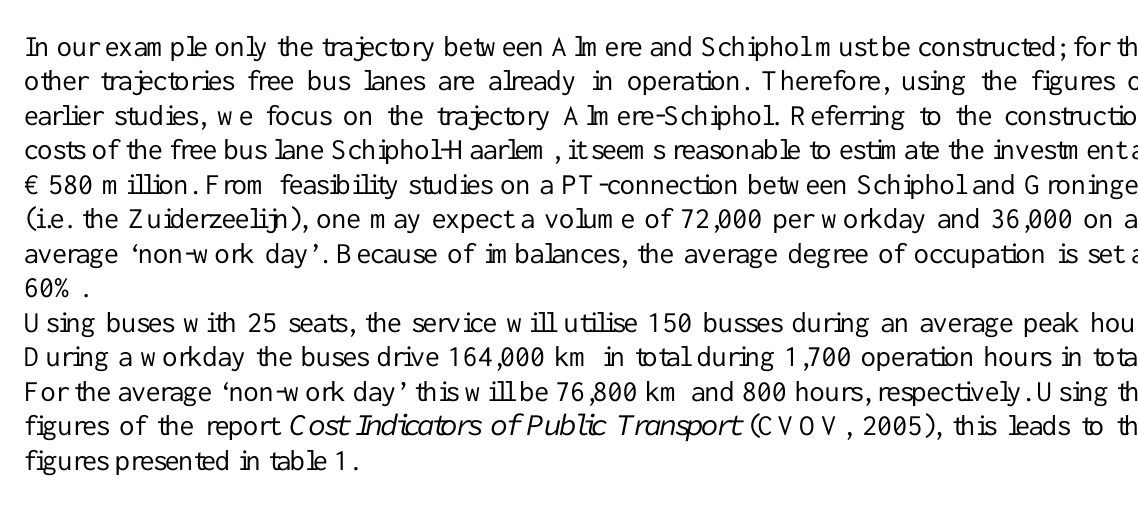
Table 1. Estimated exploitation costs FTR on the trajectory Schiphol-Almere € / year € / bus-km € / trav-km Sprint lanes: 18% of invest. 104.4